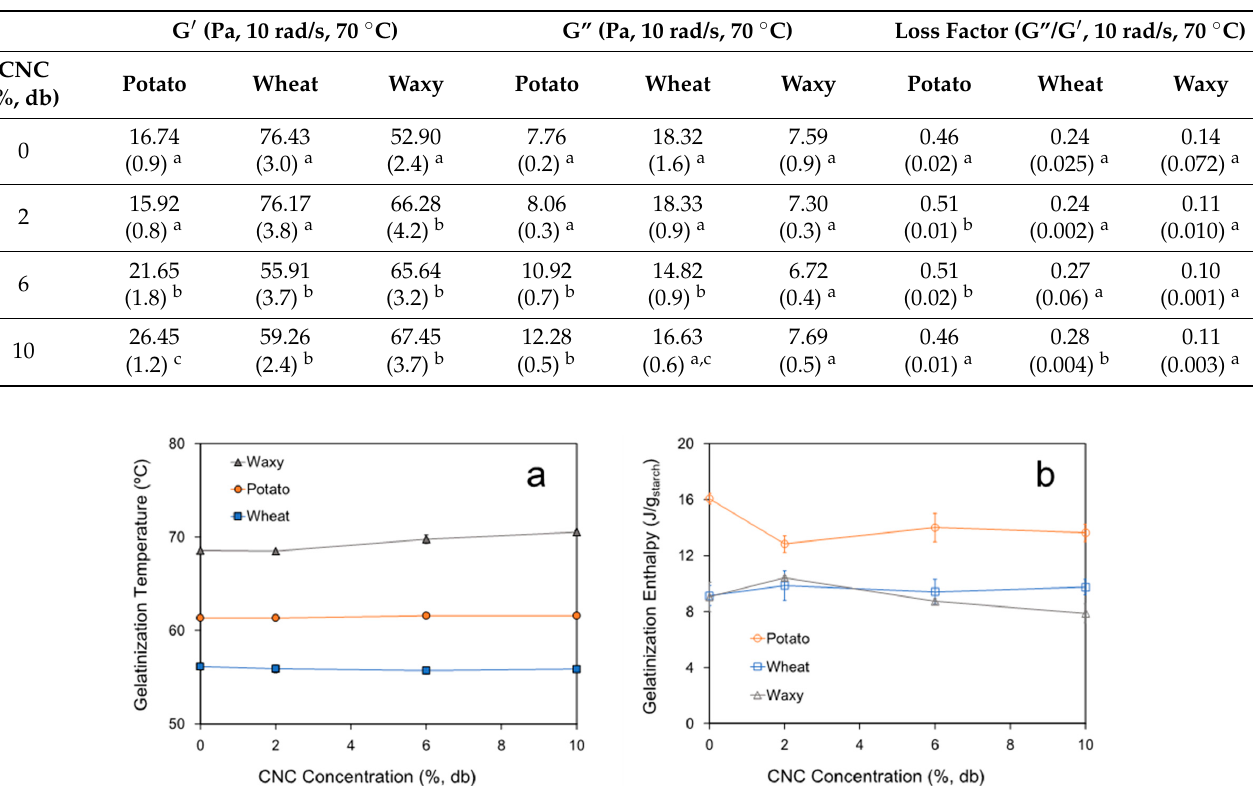
Figure 5. G (cid:48) , G” and loss factor (G”/G (cid:48) ) assessed as a function of angular frequency in gelatinized starch samples at 70 ◦ C and at different concentrations of CNCs: ( a ) potato; ( b ) wheat; and ( c ) waxy maize. Top plots correspond to a frequency sweep as a function of shear rate, whereas the bottom plots correspond to the loss factor as a function of shear rate. Table 3. G (cid:48) , G” and loss factor of starch–CNC blends assessed at an angular frequency of 10 rad/s and 70 ◦ C. Values in brackets correspond to standard deviation. Different upper letters in the same column represent significant differences ( p -value < 0.05).